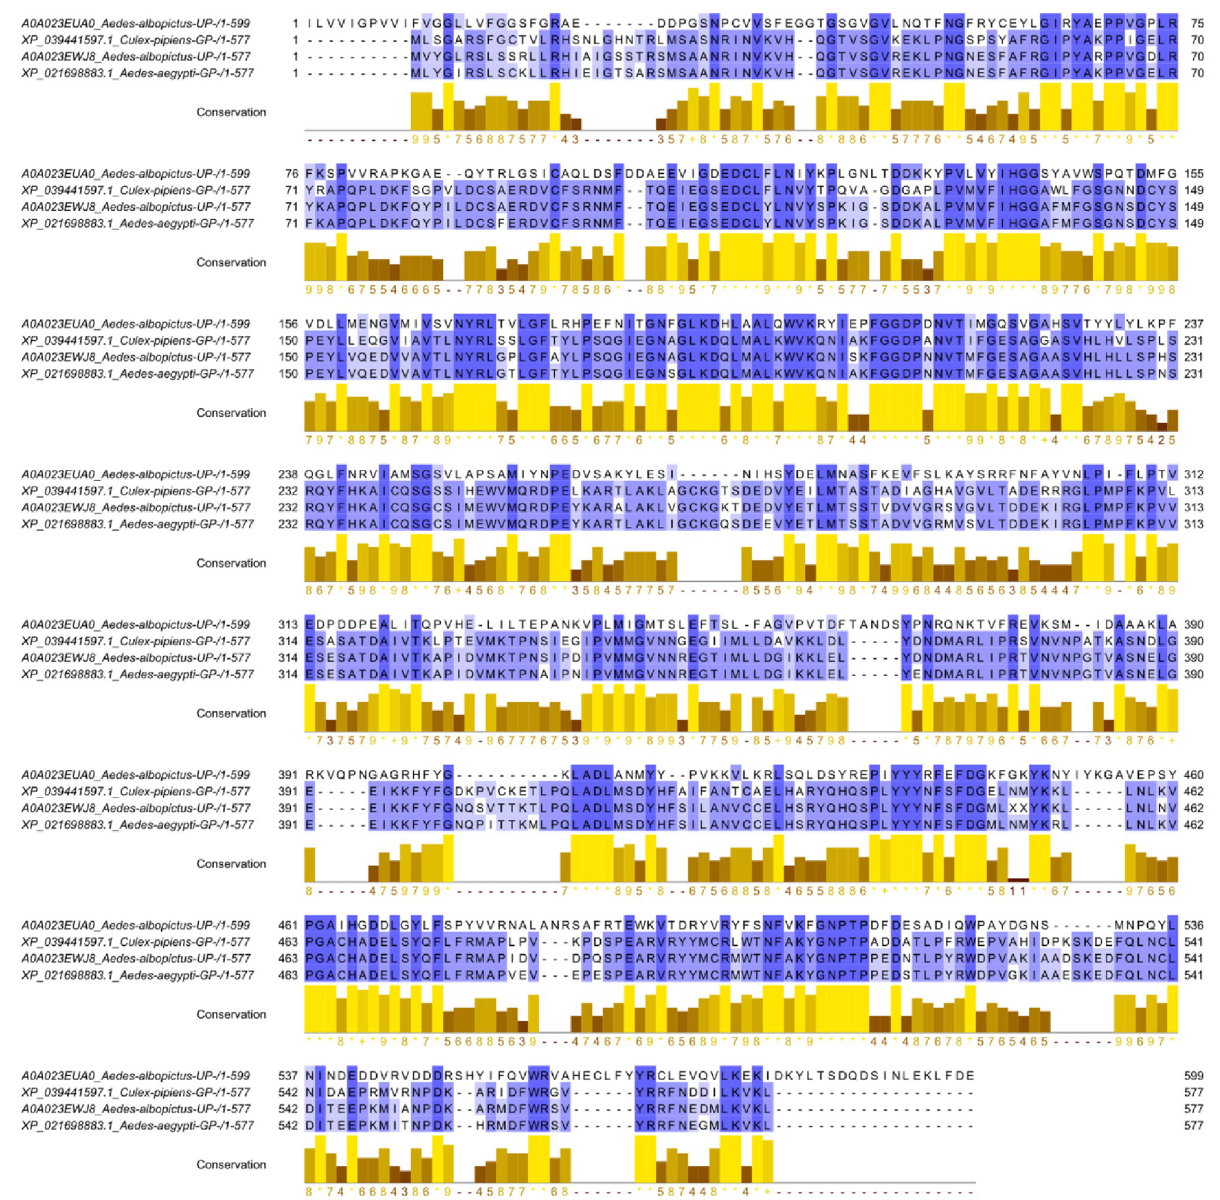
Fig 1. Multiple sequence alignment of BChE sequences from various mosquitoes and identified conserved